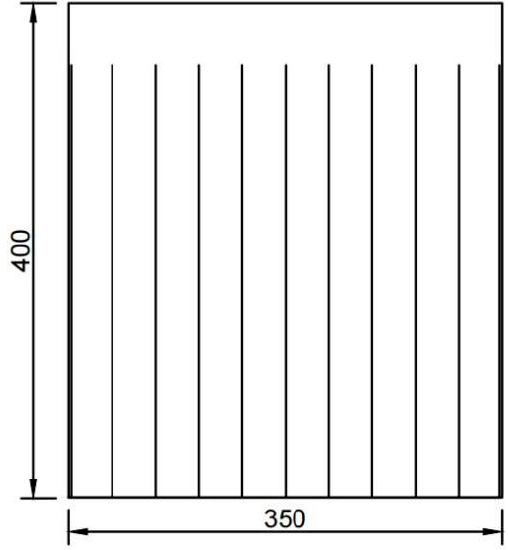
Figure 5. Geometrical dimensions of the RC shear walls.